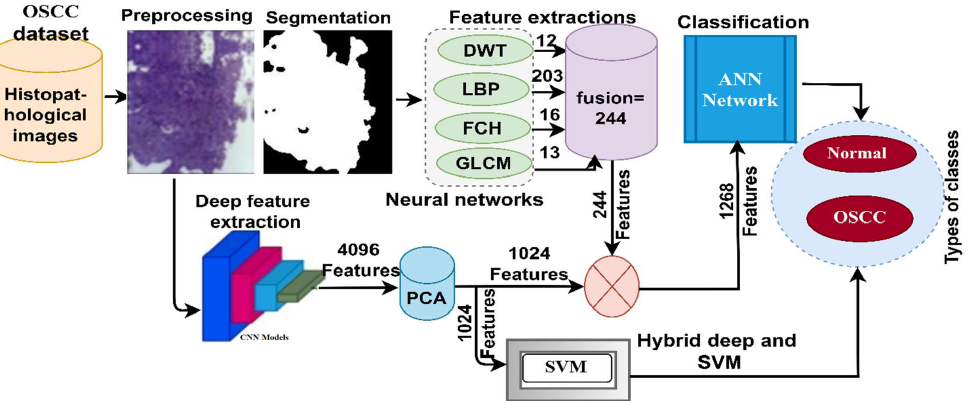
Figure 1. Structure of the histopathological image diagnostics methodology for early diagnosis of OSCC.